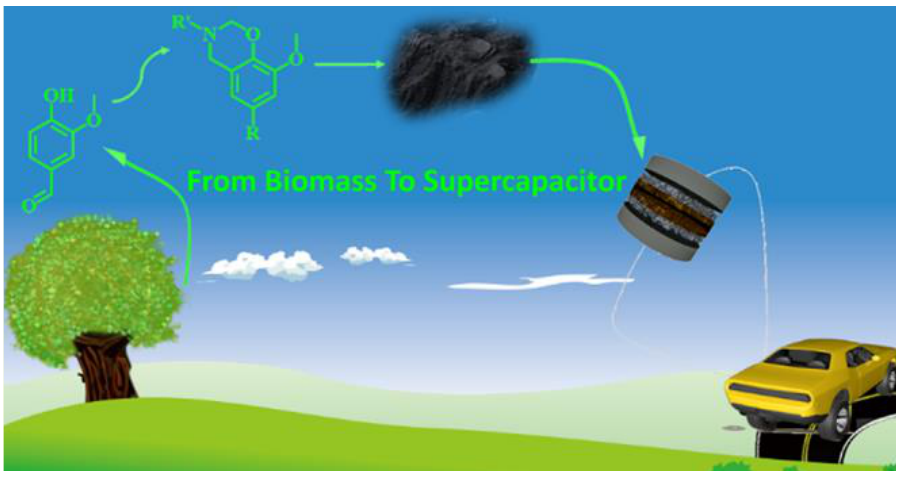
Figure 28. From biomass to supercapacitor (reproduced from the work in [77] with permission).